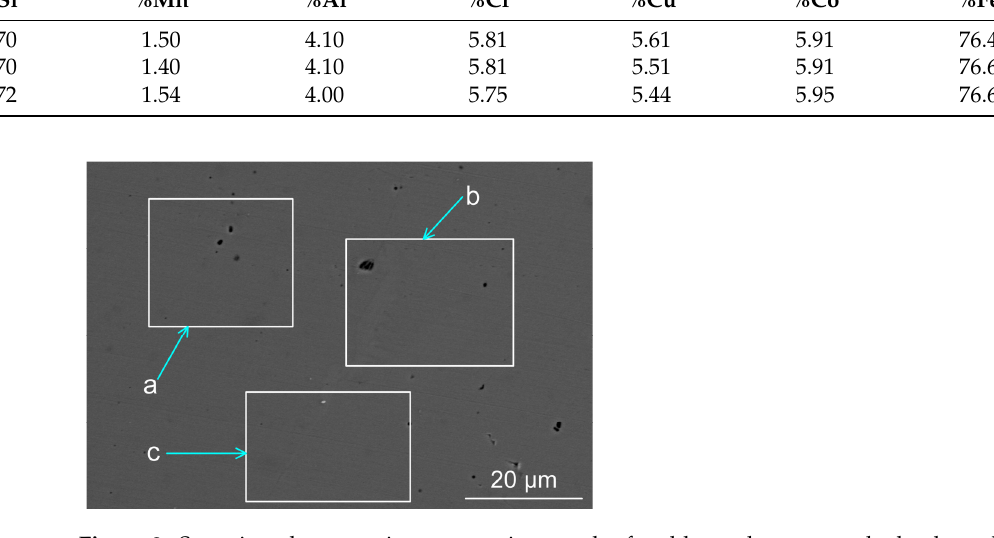
Table 2. SEM-EDX analyses of marked areas (a, b and c) in the MP11 weld metal, as indicated in Figure 2 (mass%).